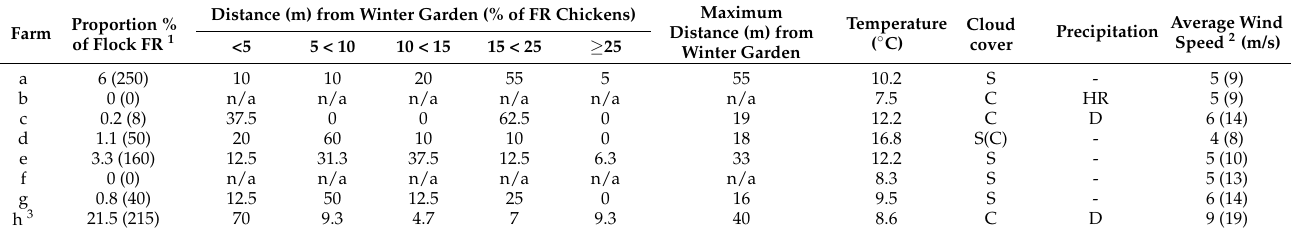
Table 6. Proportion of broiler flocks observed free-ranging (FR) on Swedish organic chicken farms ( n = 8), distance from winter garden and prevailing weather conditions (HR: heavy rain; D: drizzle; S: sunny; C: cloudy). Distance ( m ) from Winter Garden ( % Proportion % of Farm Flock FR 1